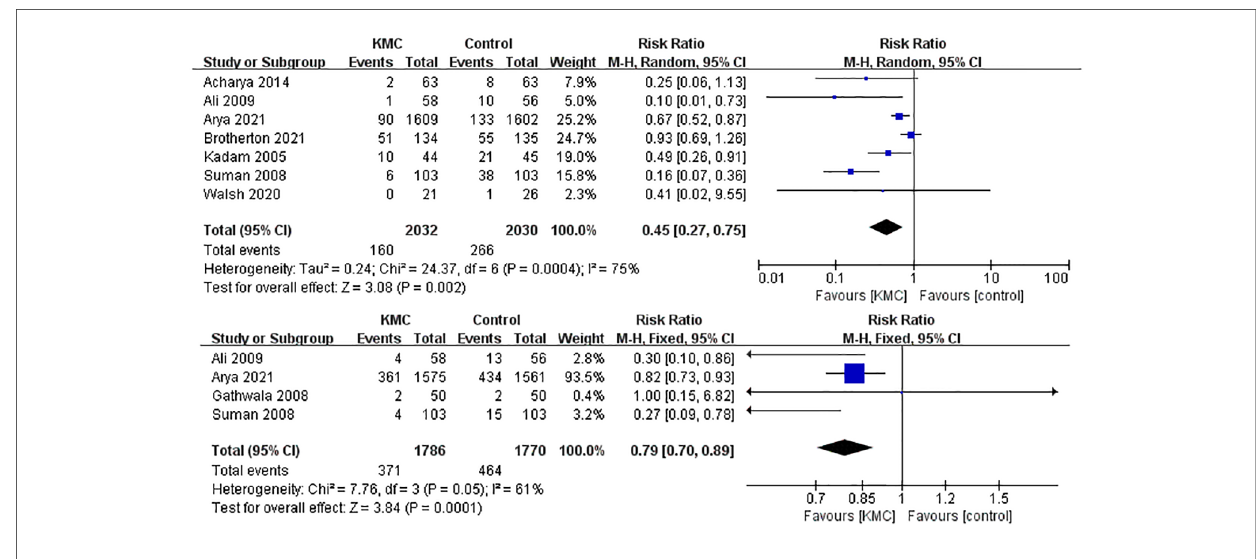
FIGURE 4 Forest plot of the hypothermia and sepsis for KMC versus control